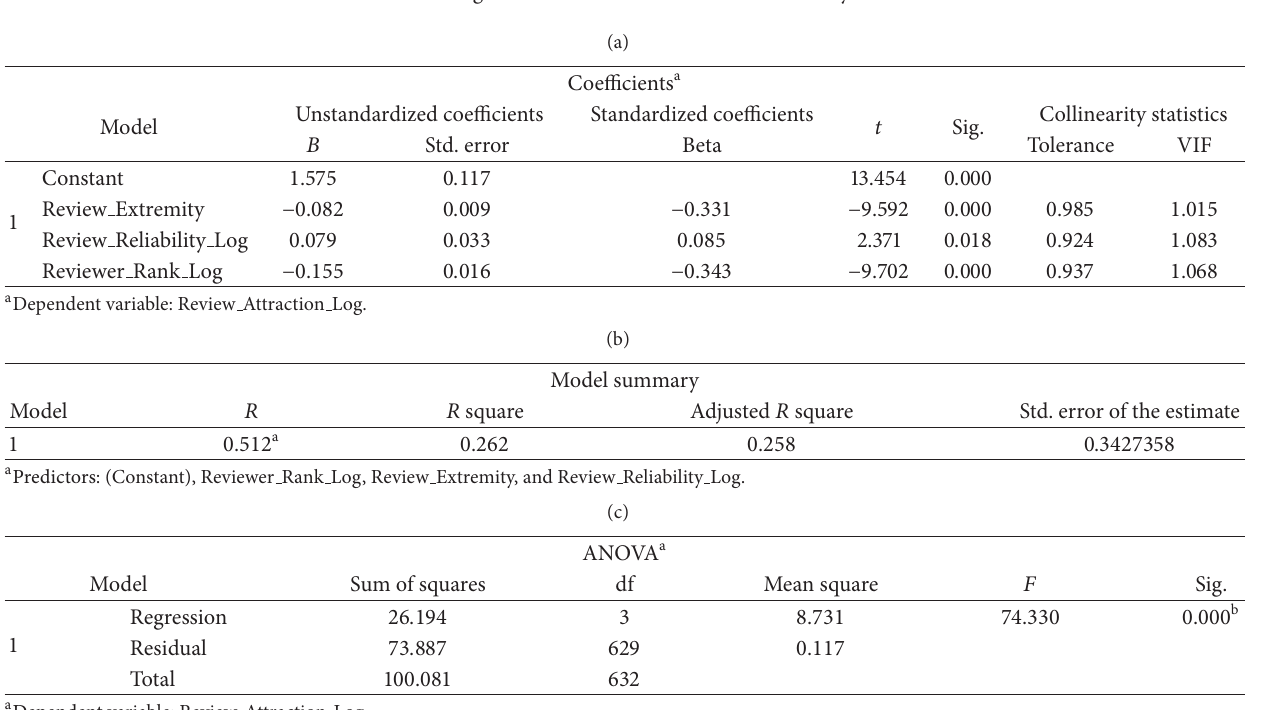
Table 8: Regression results for review attraction